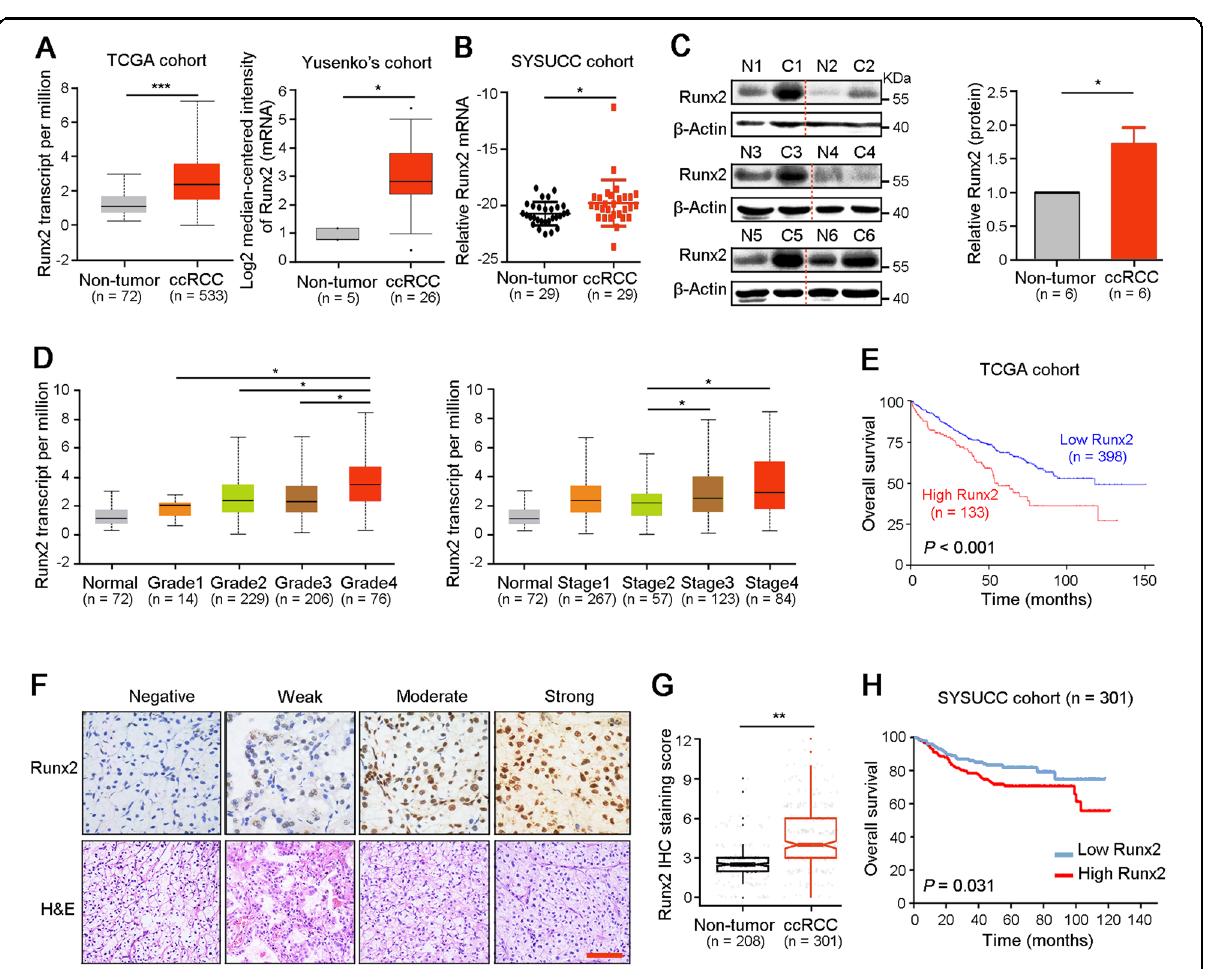
Fig. 1 High expression of Runx2 is related to the worse outcome of ccRCC patients. A TCGA and Oncomine (Yusenko ’ s cohort) database analyses showed the high level of Runx2 in ccRCC tissues than that in non-tumor renal tissues. B qRT-PCR was used to test the mRNA level of Runx2 in ccRCC and paired non-tumor renal tissues ( n = 29). C Western blot analyses of the expression of Runx2 in ccRCC and corresponding non-tumor renal tissues at protein level ( n = 6). β -Actin was also tested as a loading control. D High expression of Runx2 was associated with the poorer tumor grade and patient stage in ccRCC based on the TCGA dataset analysis. E Survival cures from TCGA cohort showed that ccRCC patients with high Runx2 had a short overall survival ( P < 0.001). F Representative images of IHC staining demonstrated the different expression level of Runx2 in ccRCC tissues. Scale bar, 40 μ m. G Score analysis of IHC staining showed the high expression of Runx2 in ccRCC tissues ( n = 208) than that in non-tumor renal tissues ( n = 301). H Kaplan – Meier survival analysis indicated that high expression of Runx2 was associated with poorer survival of patients with ccRCC ( P = 0.031). In all panels, *, P < 0.05; **, P < 0.01; ***, P <